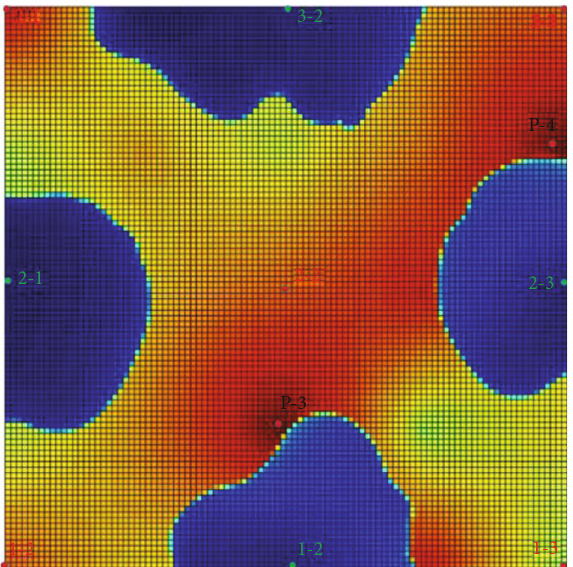
Figure 11: Schematic diagram of pattern in fi lling in scheme 2: red circle — production well; green circle — injection